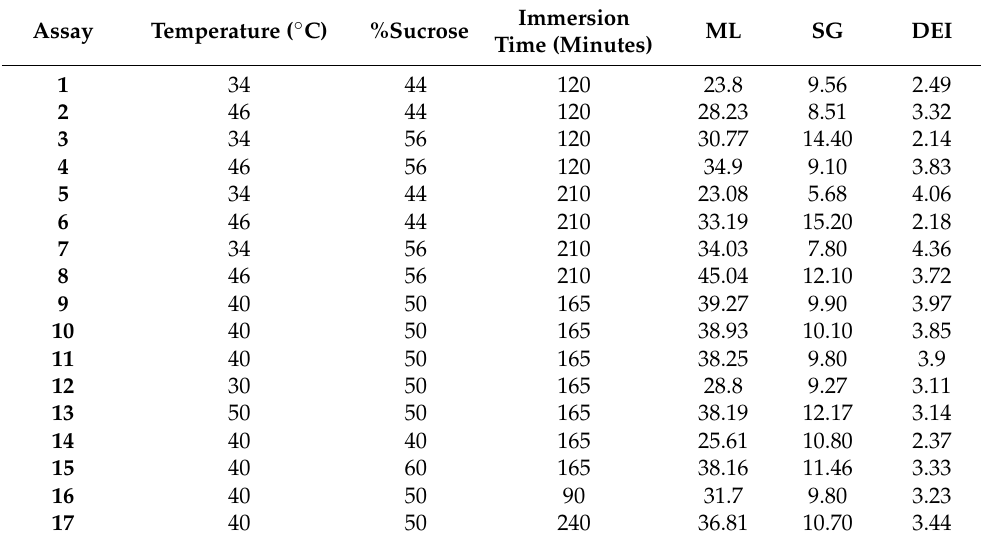
Table 2. Effects of independent variables on the ML, SG and DEI of sapodilla.